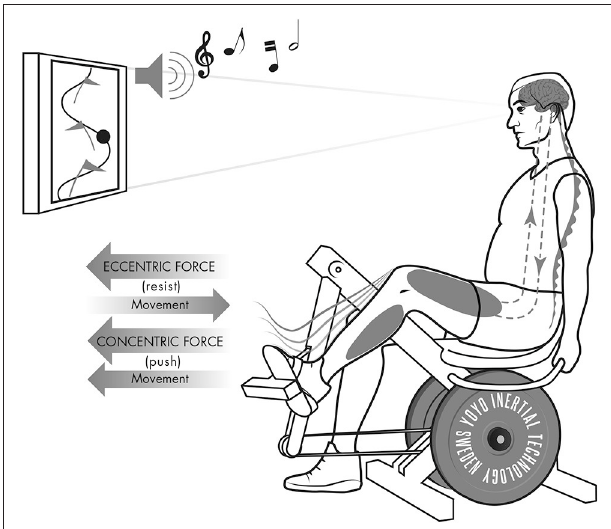
FIGURE 2 | Cartoon depicting YoYo TM Leg Press employed in a virtual reality environment. Full arrows highlight the direction of the muscle force during concentric and eccentric actions vs. the direction of the movement; dashed arrows represent the cross-talk between the central nervous system and the skeletal